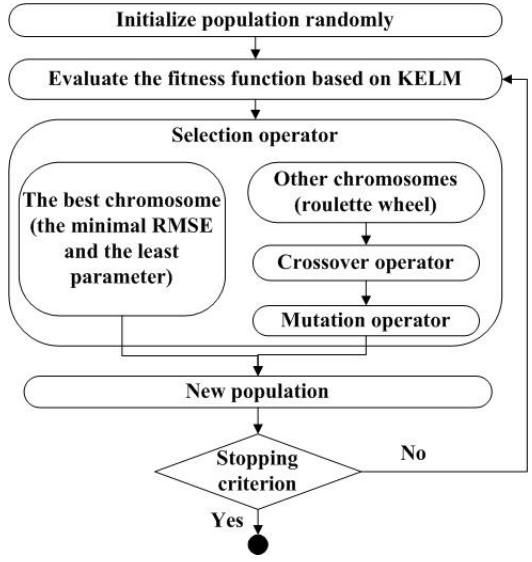
Figure 2. The process of global feature extraction algorithm based genetic algorithm (GA).